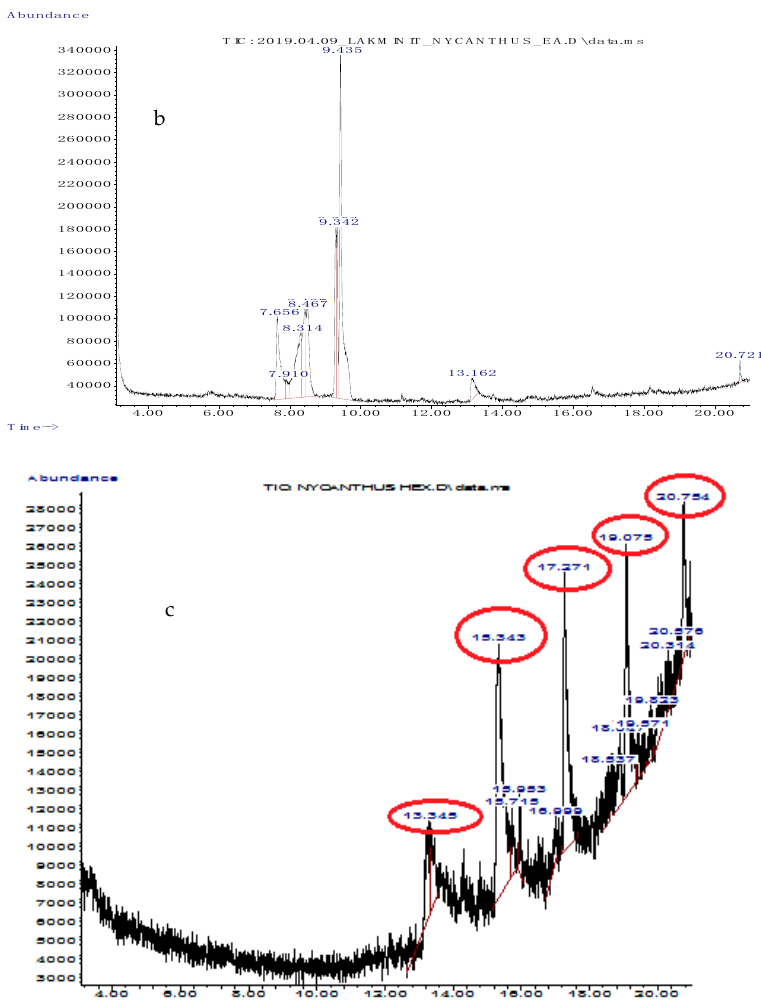
Figure 1. Chromatograms obtained from the gas chromatography / mass spectrometry (GC / MS) analysis of the chloroform fraction ( a ), ethyl acetate fraction ( b ), and hexane fraction ( c ) of the aqueous extract of Nyctanthes arbor-tristis flowers.